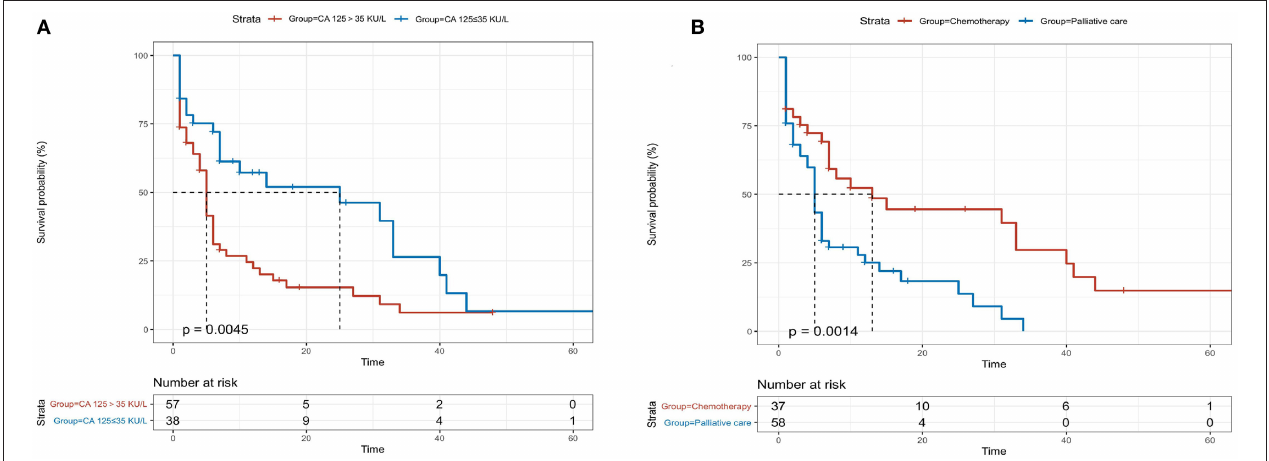
FIGURE 3 | Kaplan-Meier analysis for patients with light-chain cardiac amyloidosis (AL-CA) classified according to serum levels of CA 125 (A) and treatment with/without chemotherapy (B) . The median overall survival in elevated and normal CA 125 values were 5 months and 25 months, respectively (log rank, p = 0.0045). Patients with palliative care had a median overall survival of 5 months while the patients receiving chemotherapy had a median overall survival of 13 months (log-rank, p =